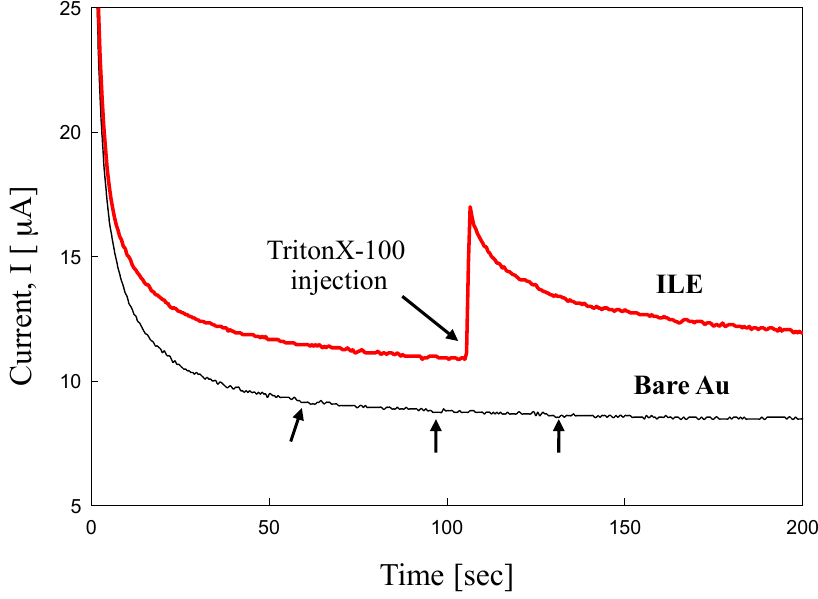
Figure 3. Chronoamperometric measurement carried out in 50 mM phosphate buffer solution using bare Au and immobilized-liposome electrode (ILE). For perturbation of membrane, 5 mM tritonX-100 solution is injected on electrochemical measurement solution (black arrows indicate injection point). Detect condition is +290 mV (vs. Ag/AgCl).